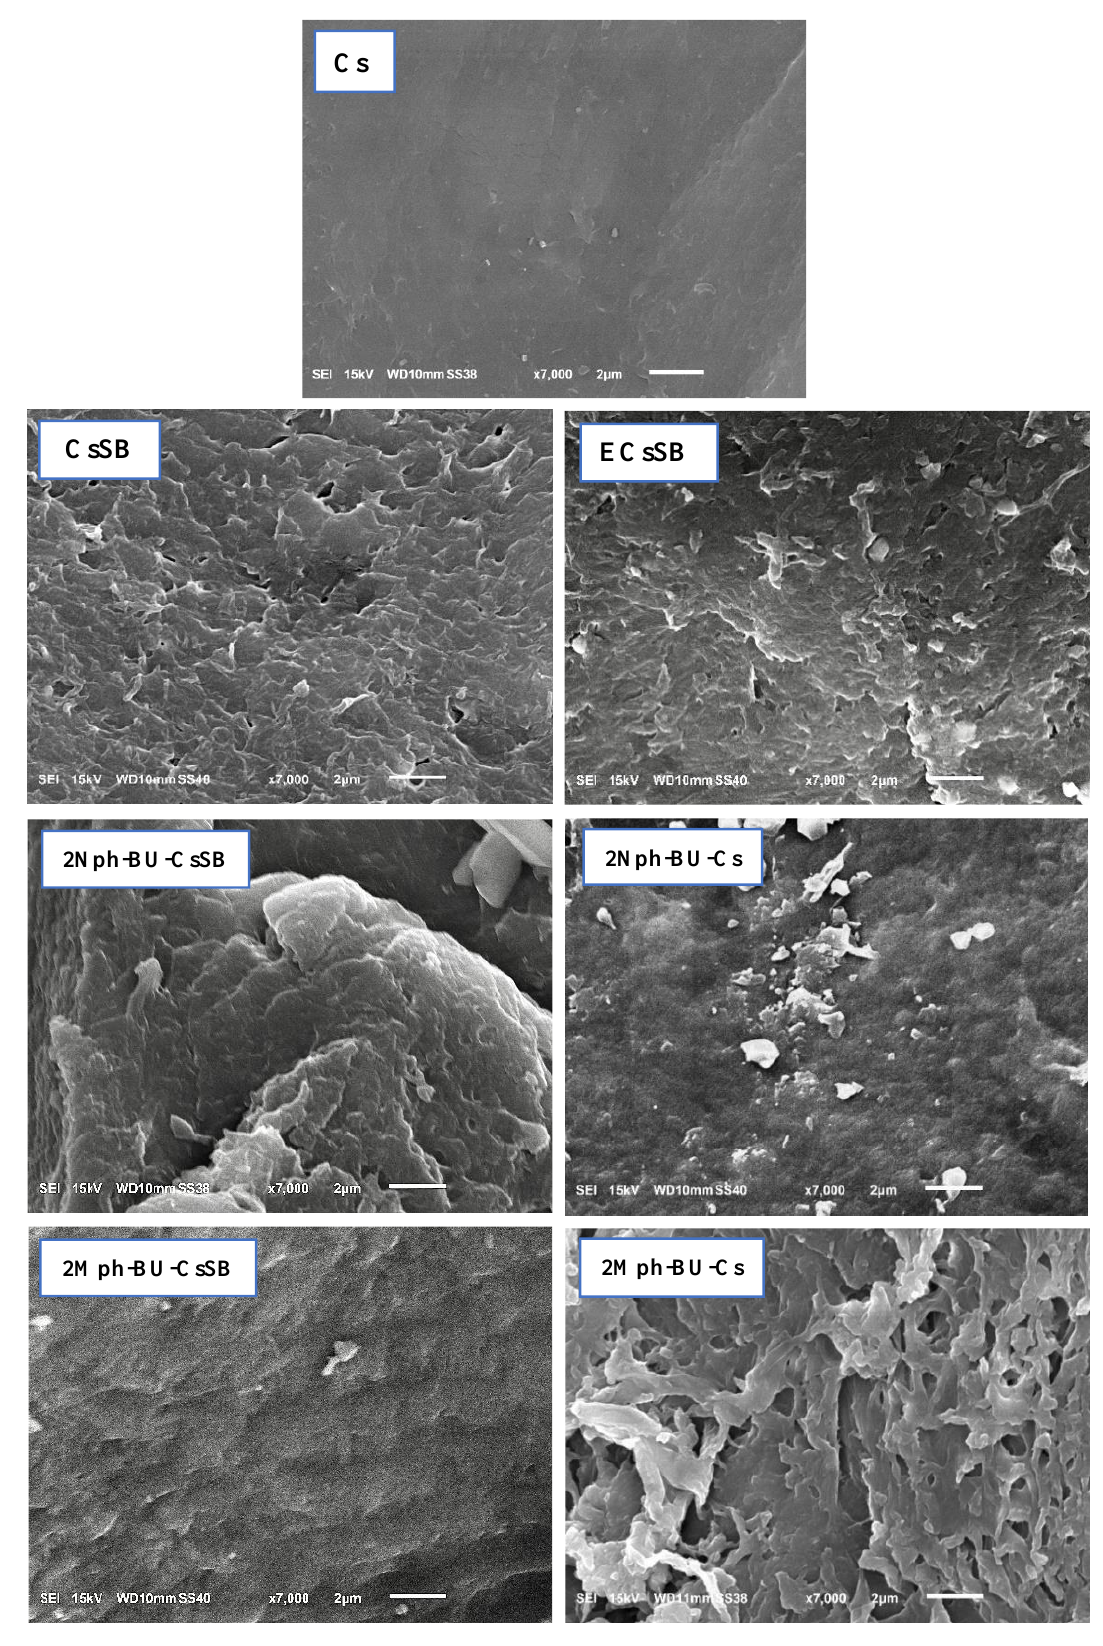
Figure 6. SEM images of 2Mph - BU-CsSB, 2Mph - BU-Cs, 2Nph - BU-CsSB, and 2Nph - BU-Cs hydrogels.